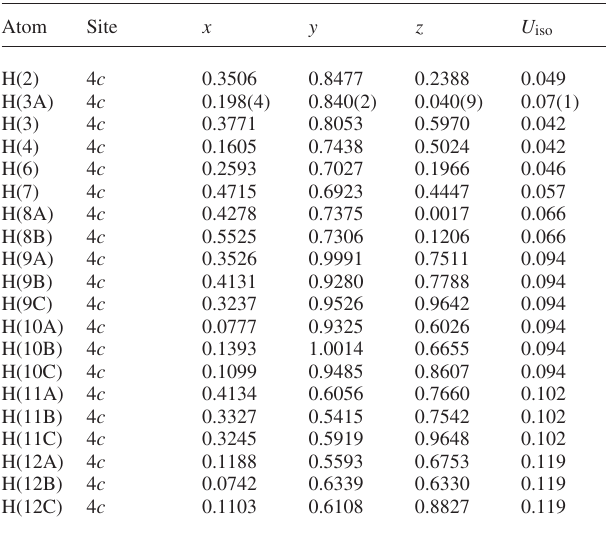
Table 2. Atomic coordinates and displacement parameters (in Å 2 )